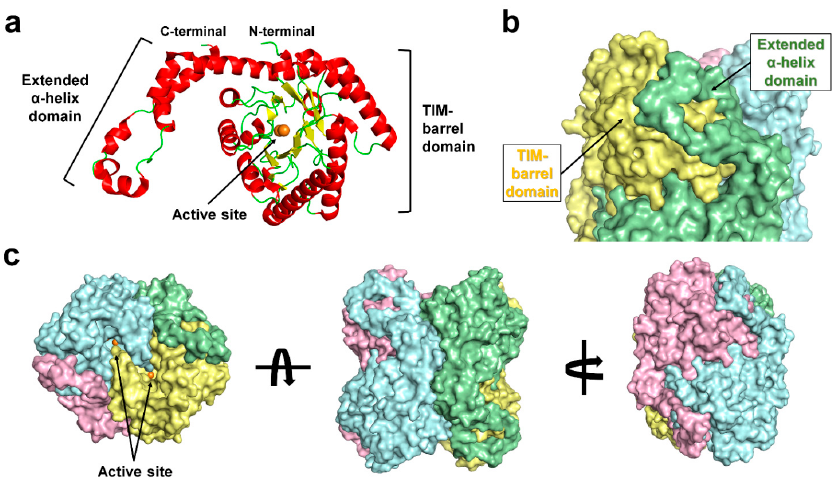
Figure 3. Crystal structure of the GI from Streptomyces rubiginosus (SruGI). ( a ) GI protomer consists of a TIM ‐ barrel domain and an extended α‐ helical domain. ( b ) The extended α‐ helical domain interacts with the TIM barrel domain from neighboring GI molecule. ( c ) Tetrameric GI shows 222 symmetry.